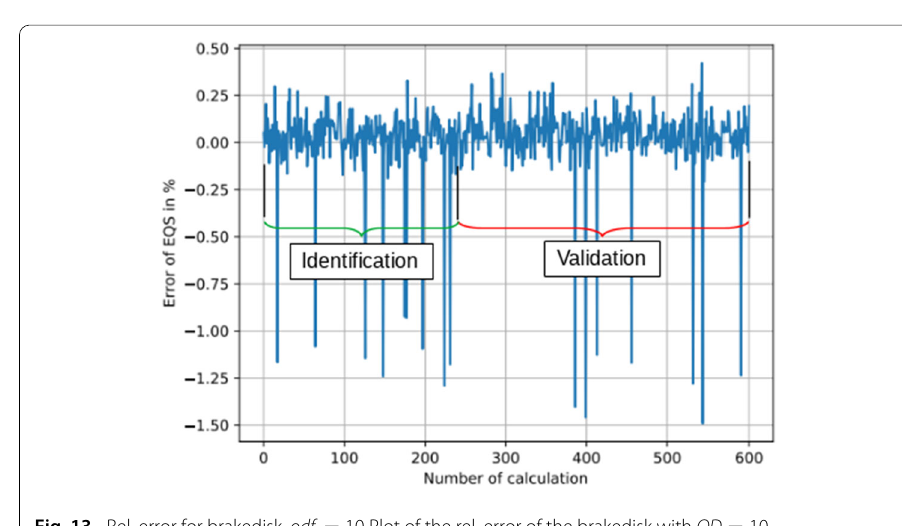
Fig. 13 Rel. error for brakedisk. odf = 10 Plot of the rel. error of the brakedisk with OD = 10